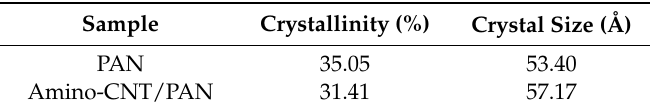
Figure 4. X-ray diffraction (XRD) patterns of ( a ) amino-CNTs, ( b ) PAN homopolymer and ( c ) amino-CNT/PAN microspheres. Table 1. XRD data of PAN homopolymer and amino-CNT/PAN microspheres, XRD: X-ray diffraction; CNT: carbon nanotube; PAN: polyacrylonitrile.